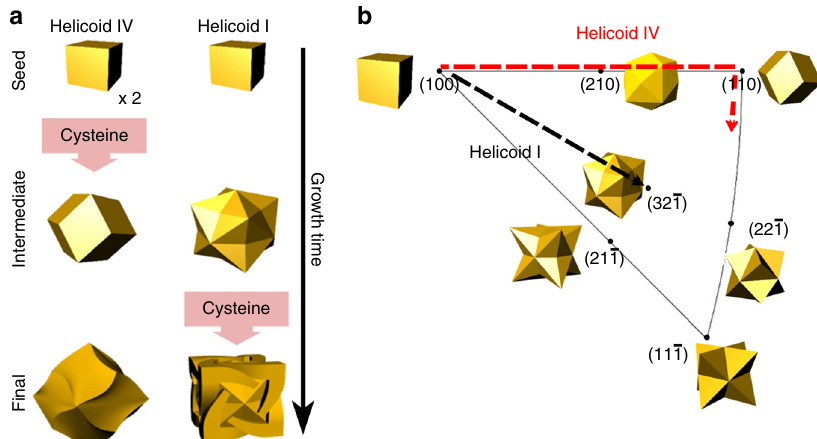
Fig. 3 Growth pathway of 432 helicoid I and IV nanoparticles. a Schematic of morphological progression of helicoids, depending on time. From the top (initial) to the bottom ( fi nal), the sequential morphology changes are described with the synthesis conditions, the injection time of cysteine, and twice amount of seed in the case of 432 helicoid IV. b Growth pathway of helicoid nanoparticles plotted on a stereographic triangle that shows representative surfaces and morphologies. The black and red dashed line show pathway of 432 helicoid I and 432 helicoid IV, respectively.